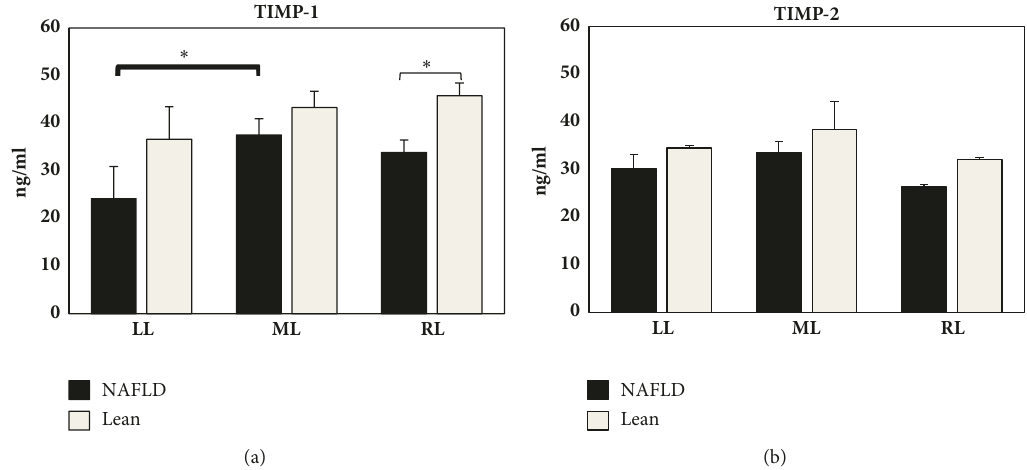
Figure 5: Hepatic content in TIMP-1 (a) and TIMP-2 (b) obtained from LL, ML, and RL in NAFLD and Lean rats. TIMP levels are expressed in ng/mL. Data are shown as mean values ± SE. ∗ p <